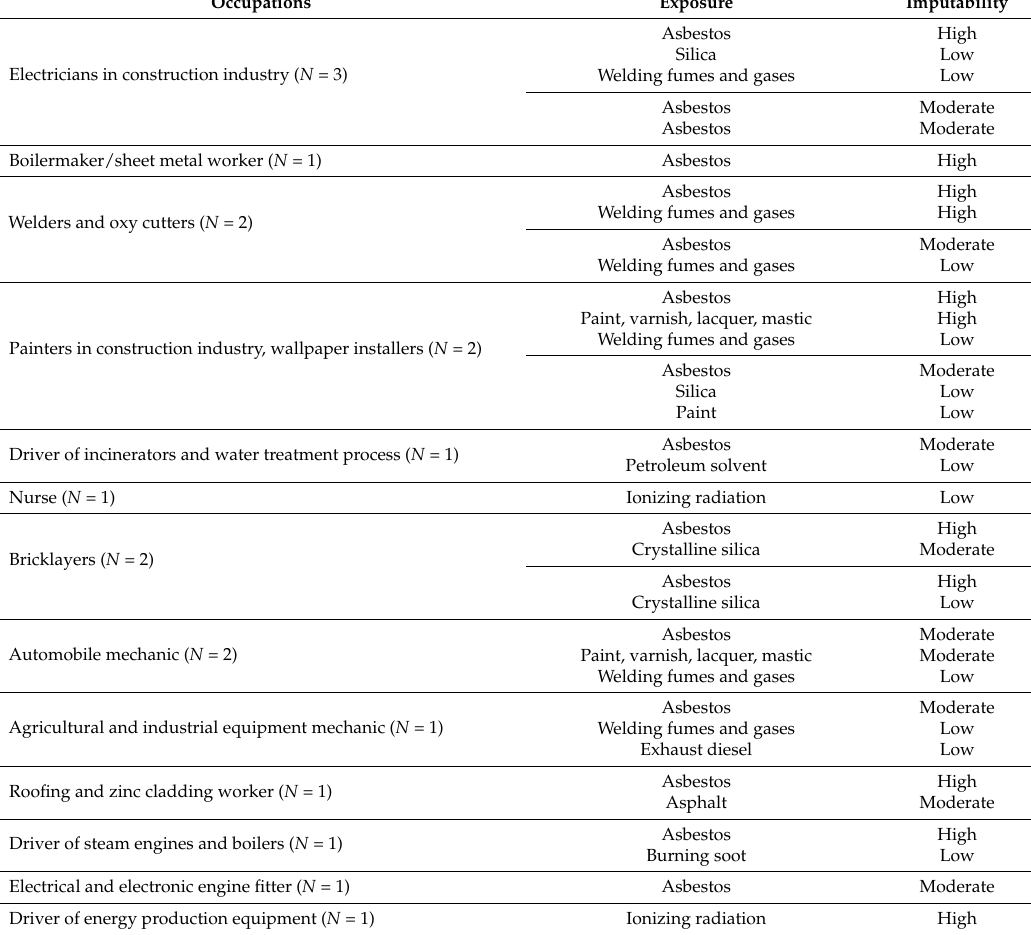
Table 4. Occupations and exposures of compensated